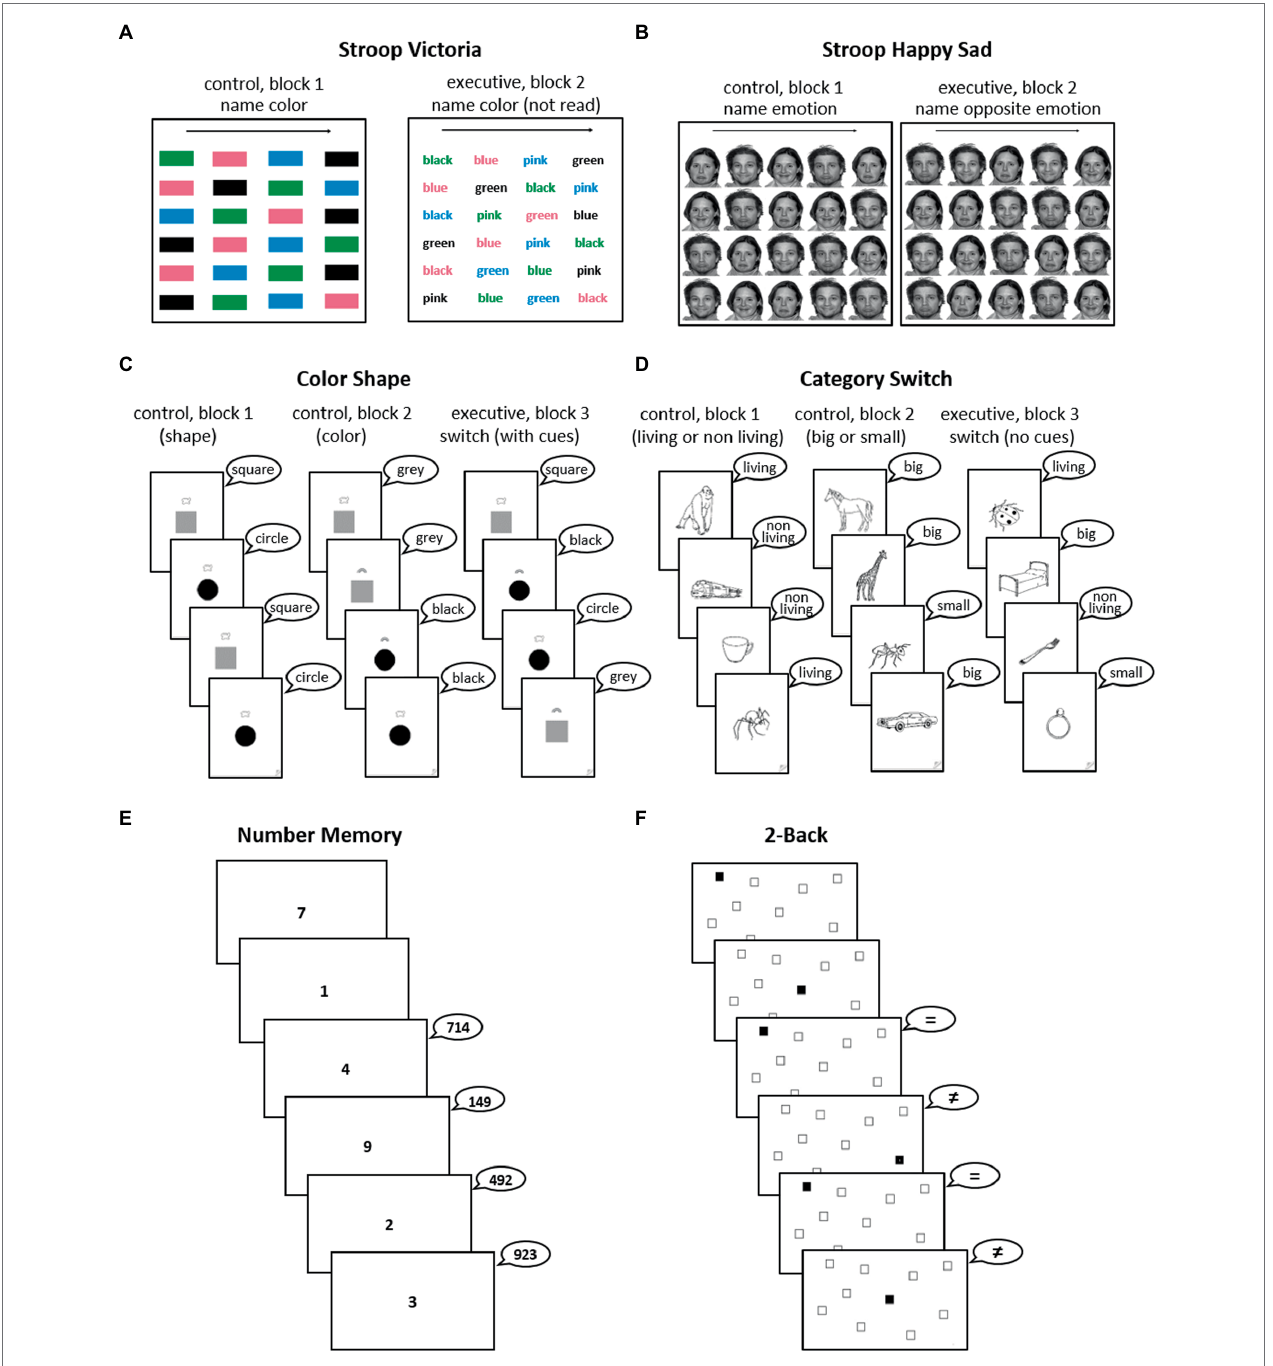
FIGURE 1 | Overview of the two tasks of each of the three executive domains: inhibition tasks (A,B) , switching tasks (C,D) and updating tasks (E,F) . In the Inhibition and Switching tasks the first blocks are the control blocks (naming characteristics of stimuli, with no executive requirements) and the last block requires executive abilities in addition to those involved in the control blocks. For details, see Table 1 and Zanini (2021). All illustrated answers in speech bubbles are